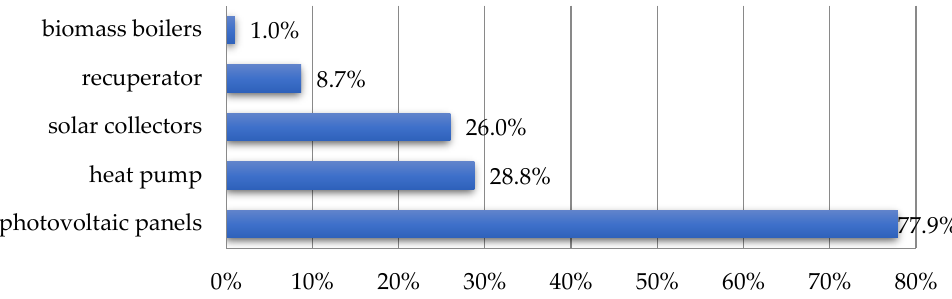
Figure 4. Structure of renewable energy installations used in households. Source: own study N = 104. Among those surveyed using renewable energy installations, nearly 78% of respon- dents indicated that they had photovoltaic panels. More than a quarter of respondents had solar panels (26.0%) or a heat pump (28.8%). By far the least popular are recuperators (8.7%) and biomass boilers